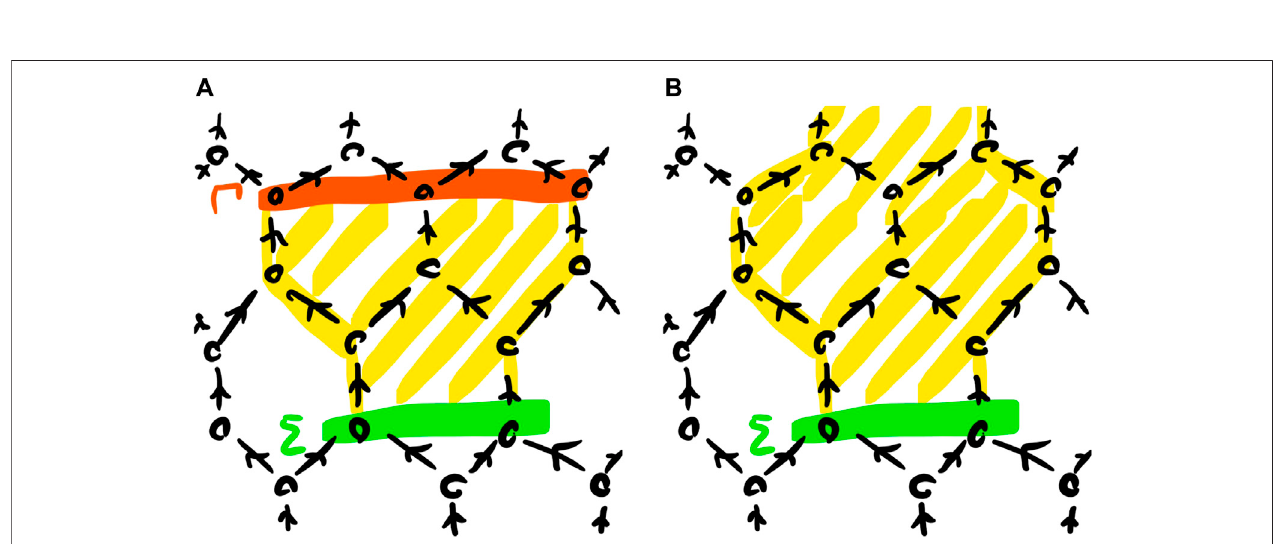
FIGURE 4 | (A) : the region between two slices on the honeycomb lattice. (B) : an unbounded (necessarily in fi nite) region on the honeycomb lattice.